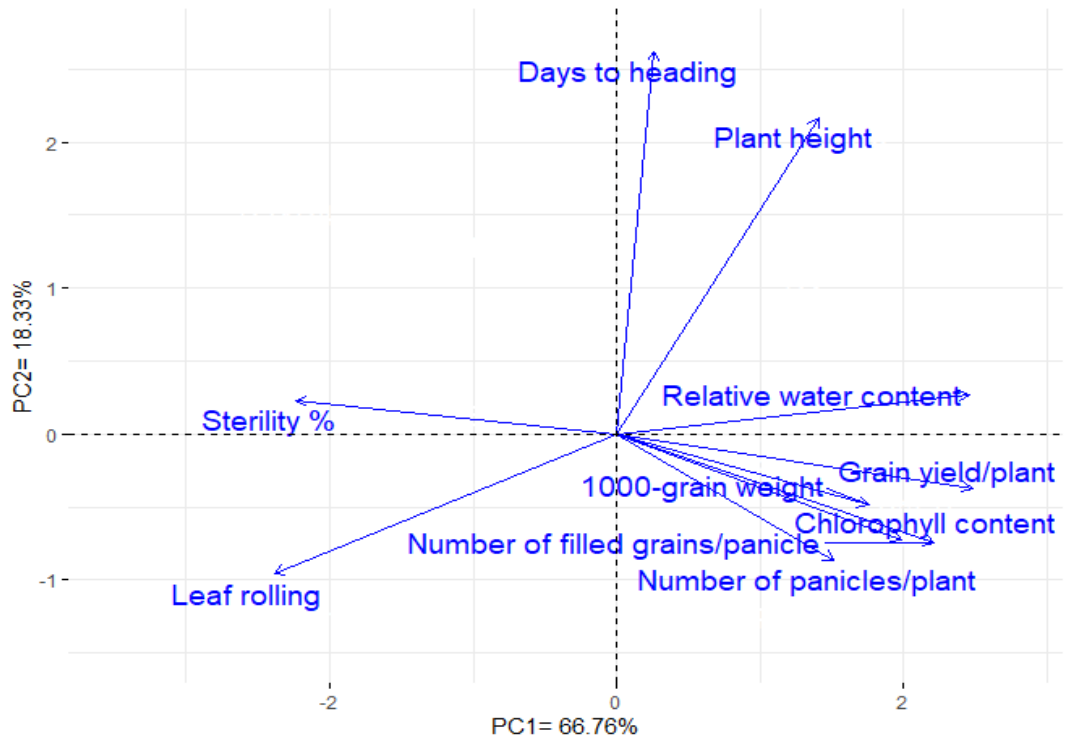
Figure 7. Biplot of principal component analysis exploring the association among the studied traits under water-deficit conditions.